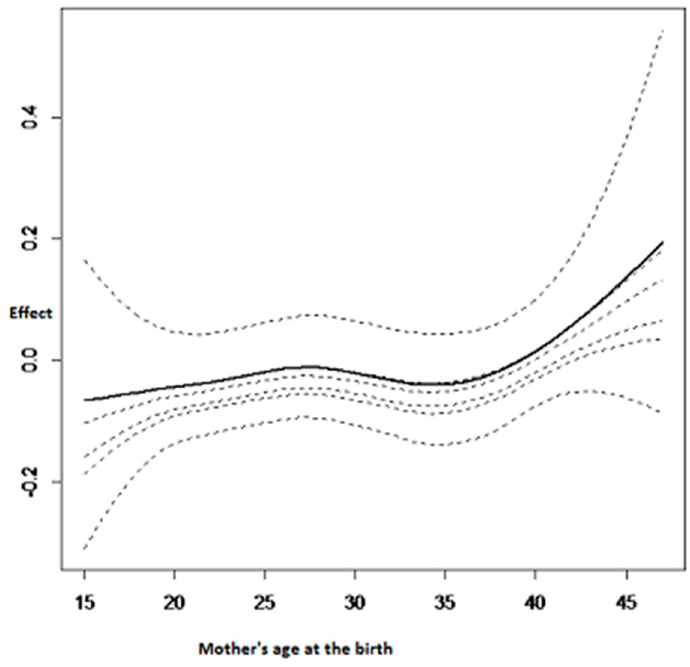
Figure 3. Nonlinear effects on childhood hemoglobin concentration: mother’s age at the birth.